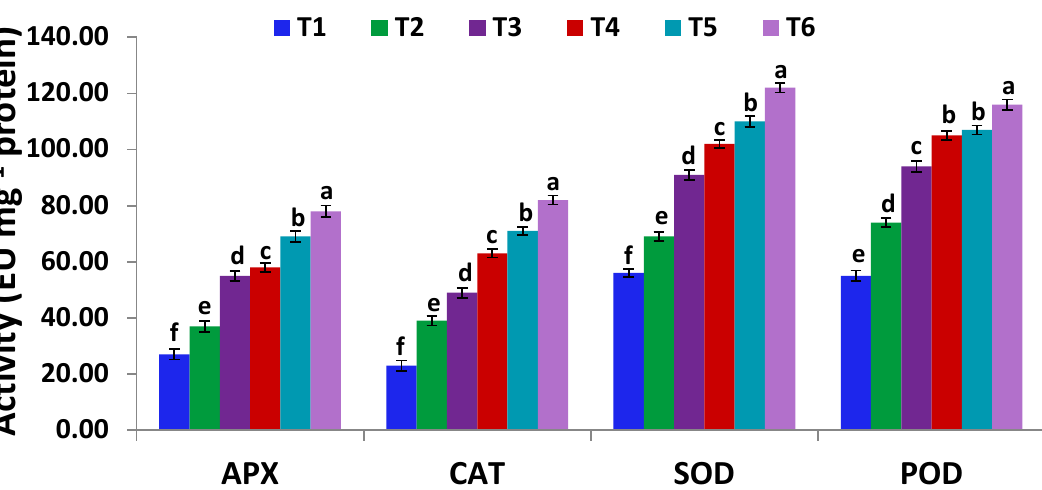
Figure 2. Ascorbate peroxidase (APX), catalase (CAT), superoxide dismutase (SOD), and peroxidase (POD) activities in leaves of un-inoculated and inoculated soybean plants with Serratia marcescens BM1 under Cd stress. Data are means ± SE ( n = 4). Di ff erent letters (a–f) above the chart columns indicate significant di ff erences between treatments ( p ≤ 0.05). T1, control with no Cd and BM1 treatment; T2, plant treated with Serratia marcescens BM1; T3, plant treated with 150 µ M CdCl 2 ; T4, plant treated with 150 µ M CdCl 2 and Serratia marcescens BM1; T5, plant treated with 300 µ M CdCl 2 ; T6, plant treated with 300 µ M CdCl 2 and Serratia marcescens BM1.